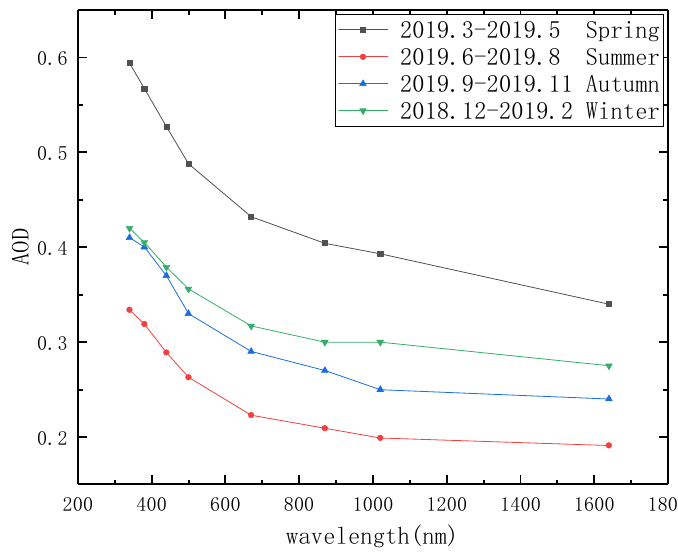
Figure 3. The average AODs of four seasons from 2018 to 2019 in Yinchuan area.